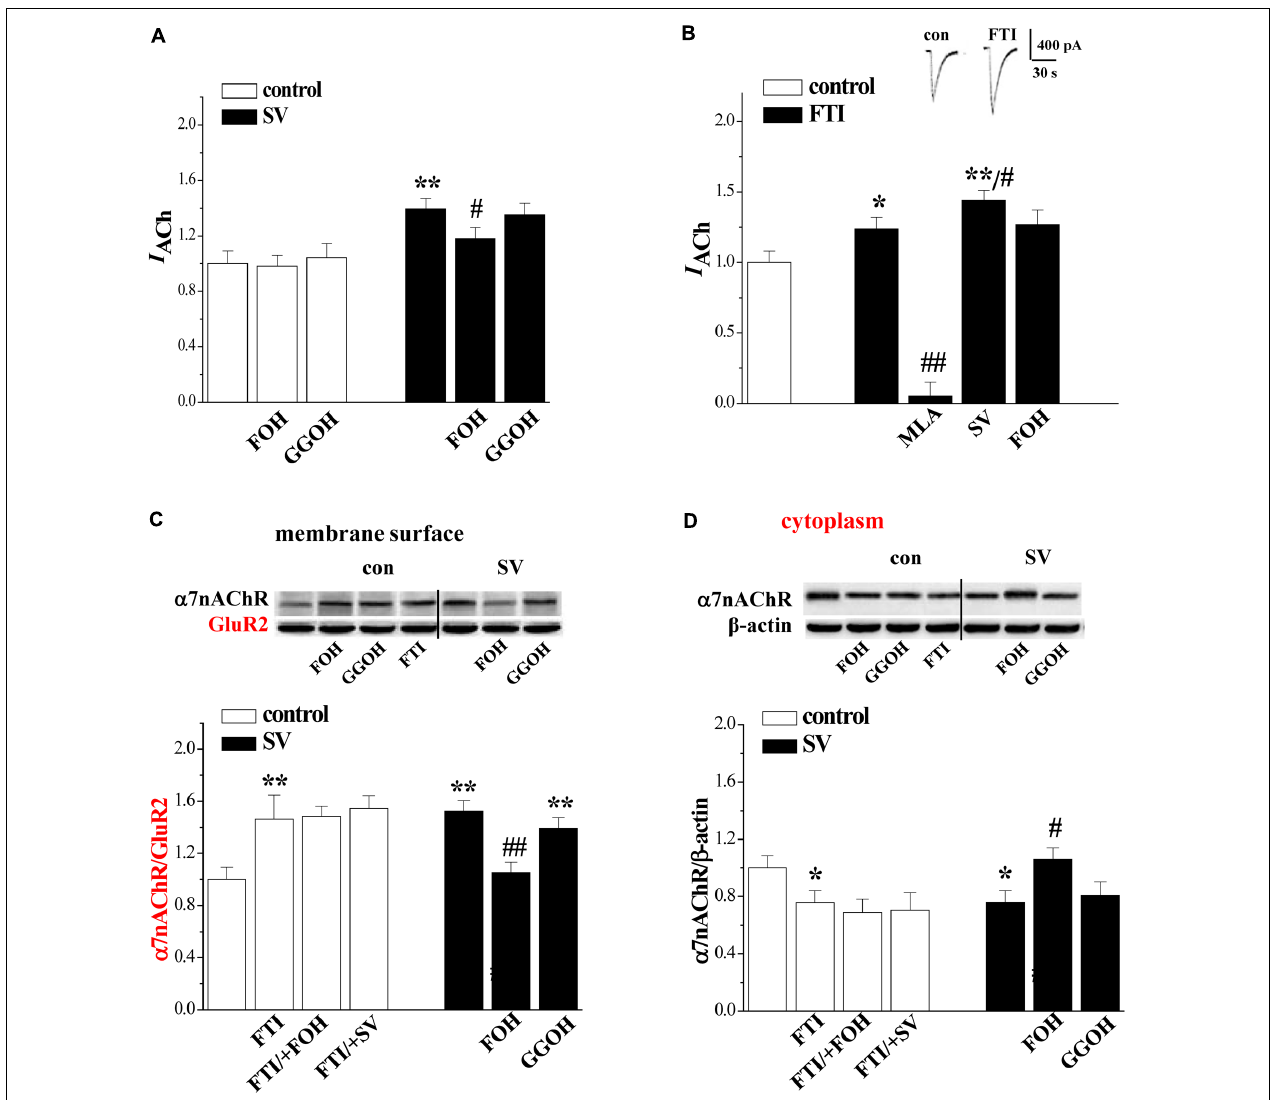
FIGURE 3 | Simvastatin through reducing FPP enhances α 7nAChR activity and trafficking. (A) Effects of FOH or GGOH addition in SV-enhanced α 7nAChR activity. Bars show the amplitude of I ACh in control slices, SV-treated slices, SV/+FOH- and SV/+GGOH-treated slices. ∗∗ p < 0.01 vs. control slices and # p < 0.05 vs. SV-treated slices (two-way ANOVA). (B) Effects of FTI on α 7nAChR activity in hippocampal CA1 pyramidal cells. Bars show the amplitude of I ACh in FTI/+MLA-, FTI/+SV- and FTI/+FOH-treated slices. ∗ p < 0.05 and ∗∗ p < 0.01 vs. control slices and # p < 0.05 and ## p < 0.01 vs. FTI-treated slices (two-way ANOVA). (C,D) Effects of FOH or GGOH addition in SV-enhanced α 7nAChR trafficking. Bar graphs show the levels of biotinylated α 7nAChR protein and cytoplasmic α 7nAChR protein in control slices, FTI-treated slices, FTI/+FOH- and FTI/+SV-treated slices, SV/+FOH- or SV/+GGOH-treated slices. Surface α 7nAChR was normalized by surface GluR2 protein and cytoplasmic α 7nAChR was normalized by β -actin. ∗ p < 0.05 and ∗∗ p < 0.01 vs. control slices. # p < 0.05 and ## p < 0.01 vs. SV-treated slices (two-way ANOVA).